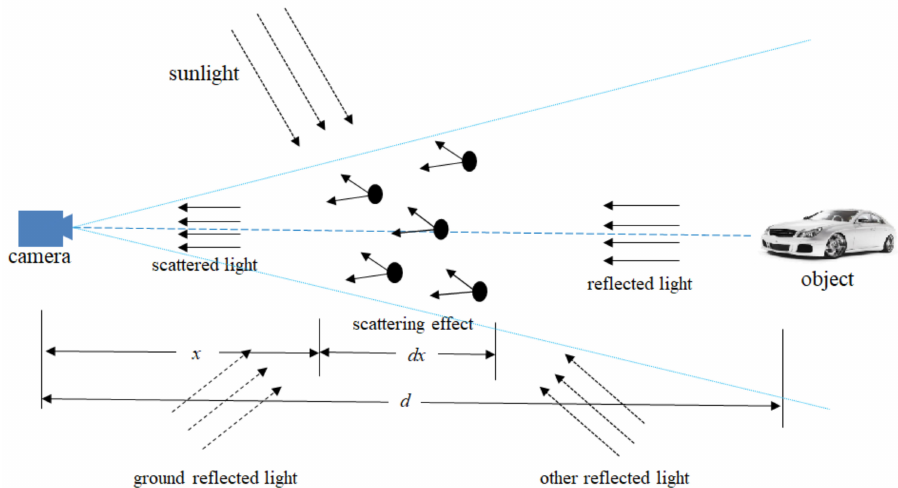
Figure 1. In foggy conditions, reflected light passes through attenuation and other interference before it reaches the imaging equipment from the target object, and the solid line shows atmospheric attenuation and the dotted line shows light